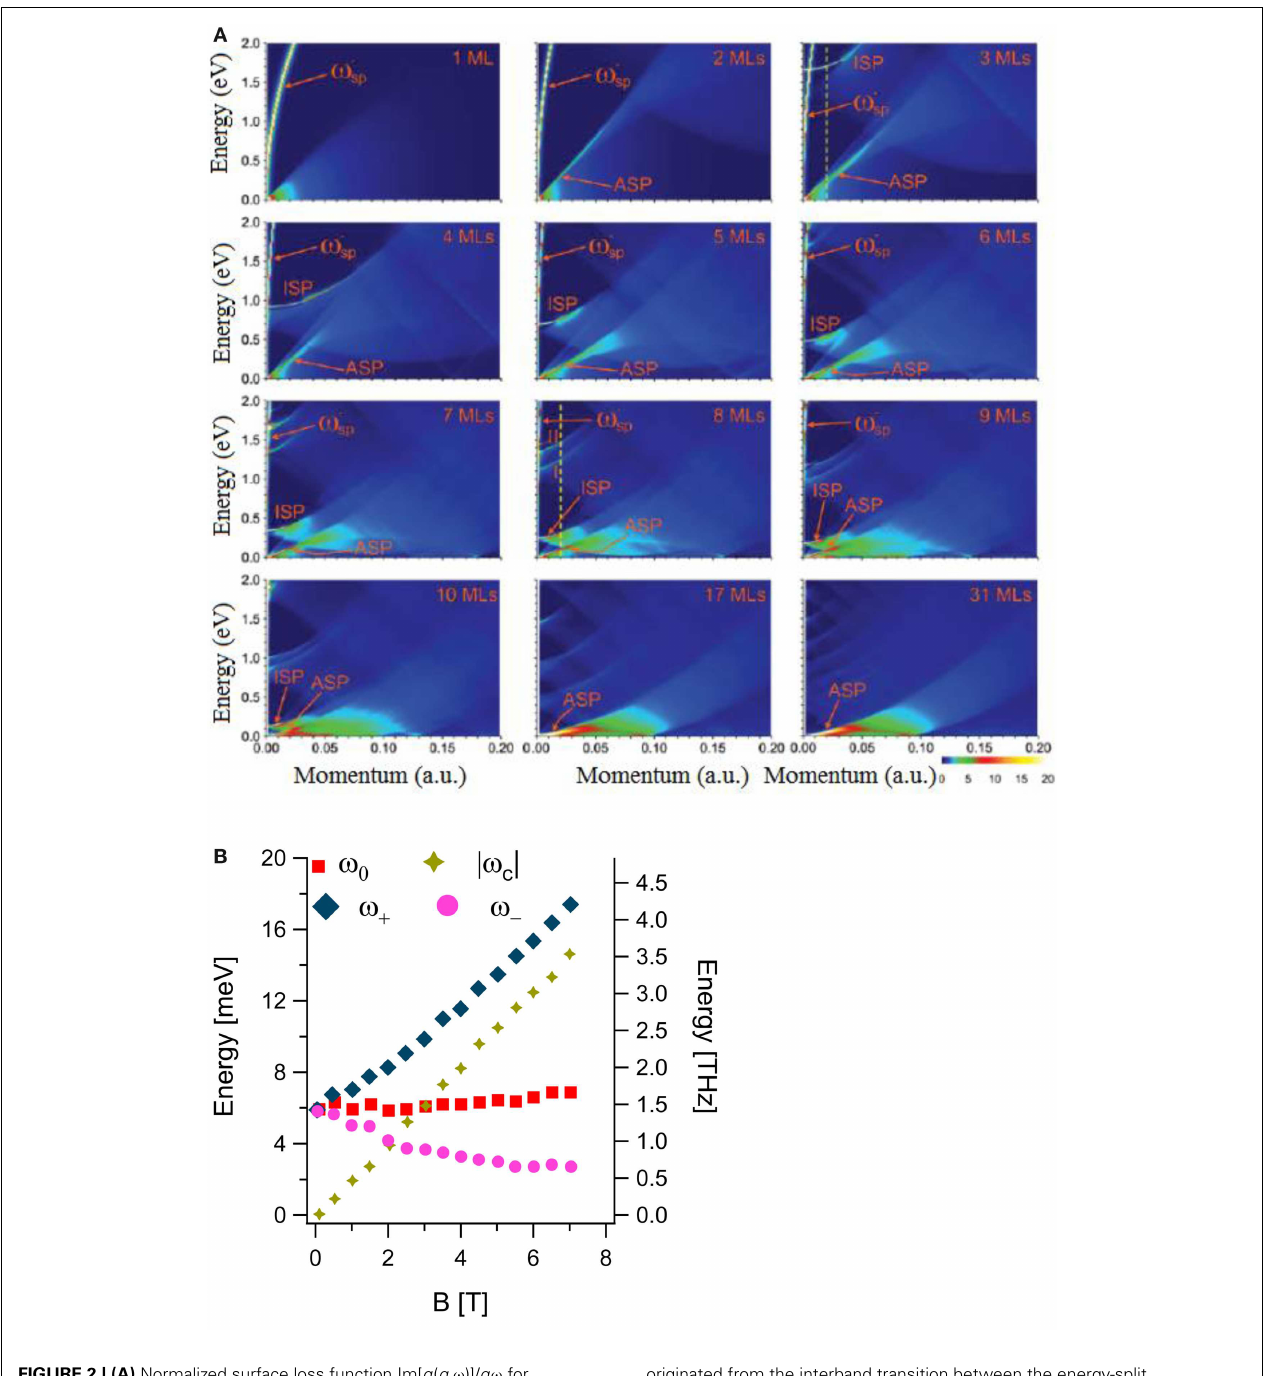
FIGURE 2 | (A) Normalized surface loss function Im[ g ( q , ω )]/ q ω for Ag(111) films with thickness ranging from 1 to 31 monolayers (ML) evaluated by using realistic effective masses in energy band dispersions. Note the strongly dispersing mode corresponding to a conventional ω − SP mode of a thin film. Peaks denoted with “ISP” are